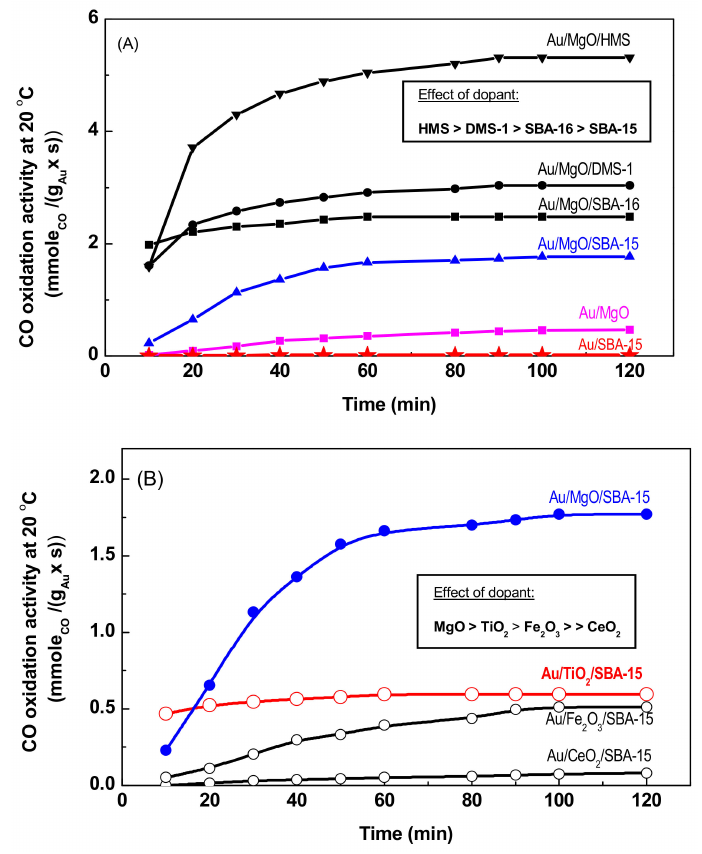
Figure 10. Influence of the support structural properties ( A ) and type of dopant ( B ) on the catalytic response of MSM-based gold catalysts in the total CO oxidation at 20 ◦ C. Gold catalysts were exposed to 1 vol % of CO and 1 vol % of O 2 (balanced with N 2 to 1 atm) at 20 ◦ C for 10 min. The Au/MgO and Au/SBA-15 were the reference samples. Solid and open symbols are used for irreducible and reducible dopants,